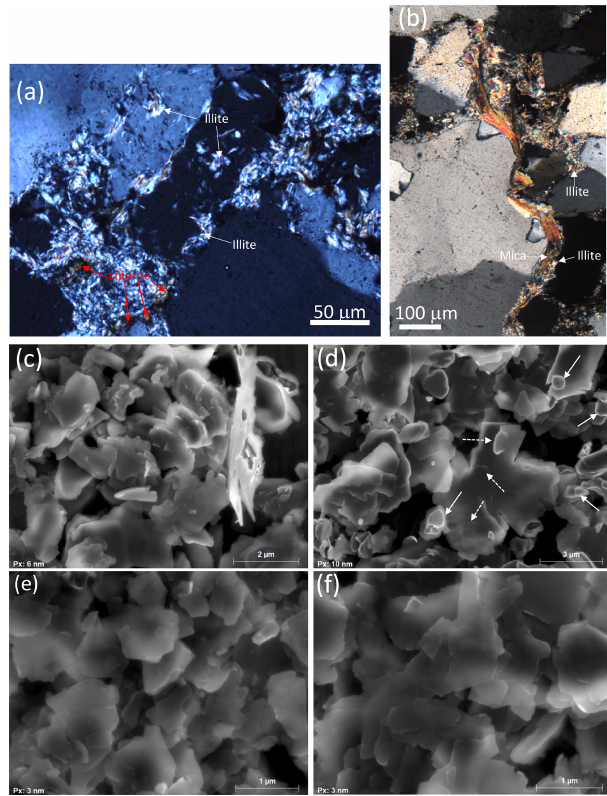
Figure 3. Thin section photomicrographs (a–b) and SEM images (c–f) illustrating fault gouge illites from the Millungera Basis. (a) Il- lite plates (white) occur in voids within detrital quartz grains and as pore-filling clay together with chlorite between detrital grains. Note green–yellow chlorite shown by the red arrow. (b) Alteration of detrital muscovite in illite. Note illite plates at the ends of the mica-filling pores. (c) SEM image of sample Dob-441. Note the large detrital mica grain ( > 2µm) with diffuse-blurred and irregu- lar edges (the white material on the right-hand side), while authi- genic illites occur in smaller crystals ( < 2µm) with straight edges. SEM image of upper anchizone and epizone sample Dob-476.6. Note the rounded smaller crystals (arrows), which occur partly as a constituent of larger illite plates (dashed arrows). (e–f) SEM im- ages of samples JC-408 and JC-360.7, respectively. Note the euhe- dral (hexagonal) and anhedral crystal plates with sharp and straight edges of these JC samples, which occur in a smaller crystal size in comparison to the Dob samples. Smaller crystal size is consistent with higher KI values of JC samples (see Table